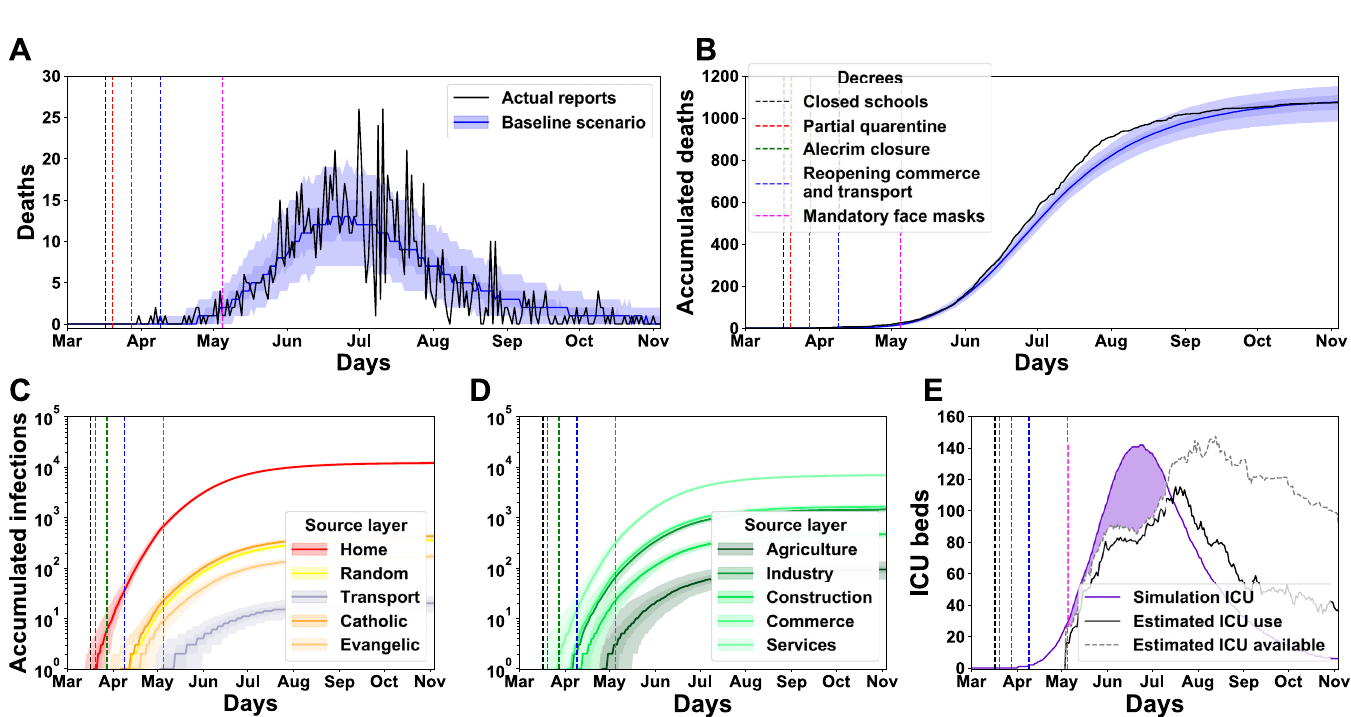
Fig 5. Baseline simulation from the agent model provides a good fit for epidemiological data on the first wave of the SARS-CoV-2 epidemic in the City of Natal, Brazil. (A) Daily and (B) accumulated deaths during the first wave of the SARS-CoV-2 outbreak in the City of Natal (from the end of February to the beginning of October) from simulation (blue) and actual reports (black). Vertical lines indicate the dates of publication of governmental decrees. (C and D) The accumulated number of infections originated in each layer or sub-layer. Simulation data from (A to D) were reported as median and quartiles (5%, 25%, 75%, 95%) from 500 runs. (E) Model- predicted ICU requirement (solid purple line, median) and excess (purple area) from estimated daily availability (silver dashed line) and the actual estimated occupation (black line) of ICU beds for the City of Natal.